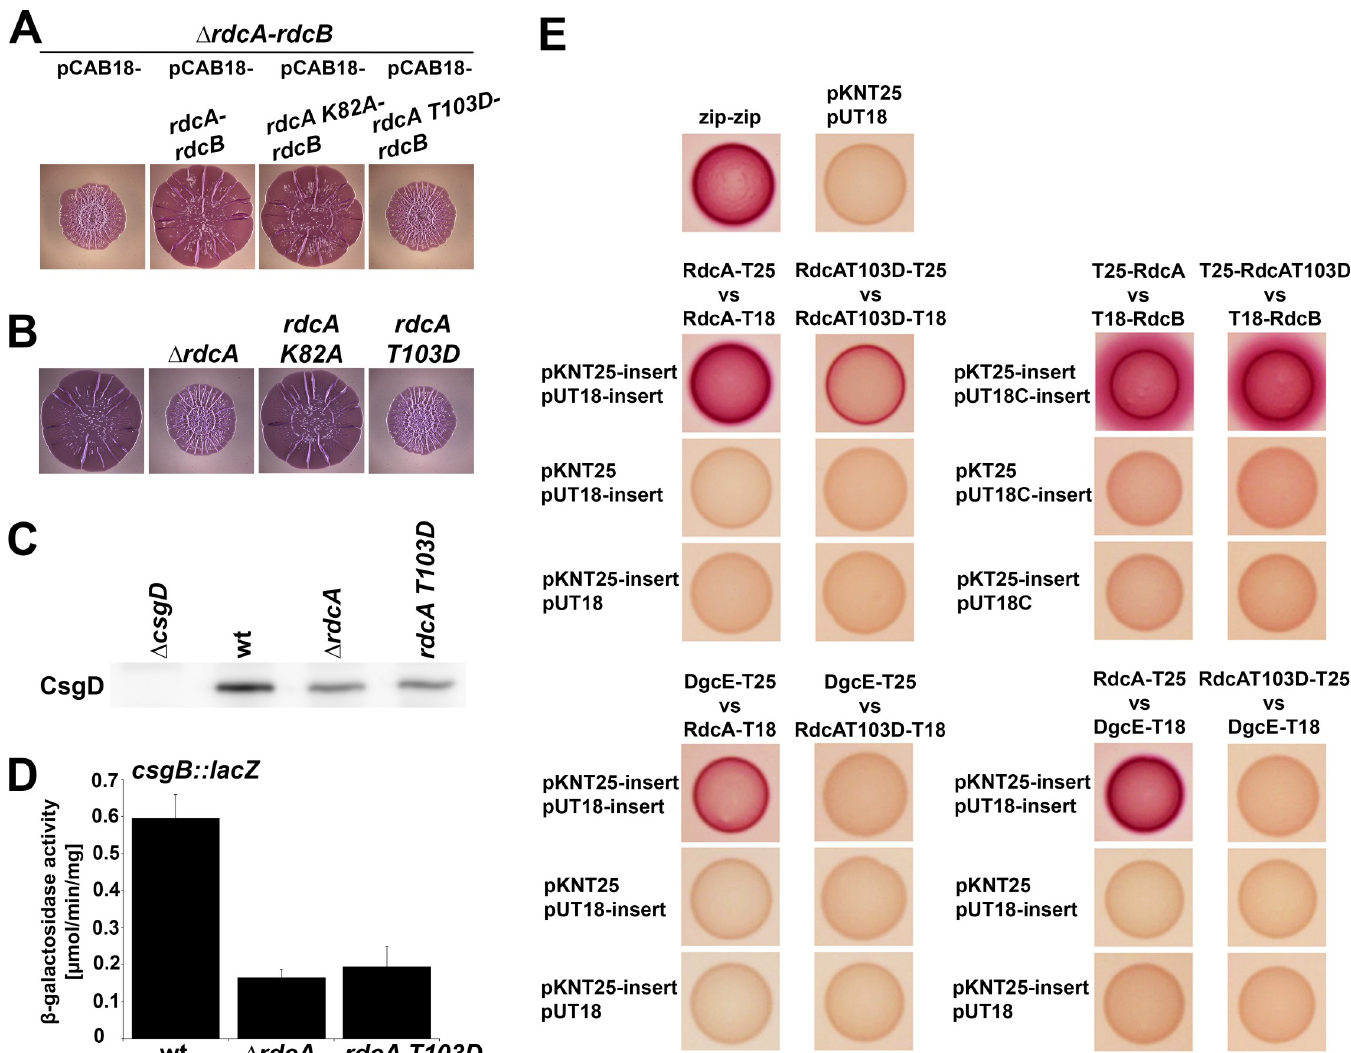
Fig 6. GTPase activity of RdcA is crucial for the activity of the RdcA-DgcE pathway. A: Macrocolony phenotypes of a Δ (rdcA-rdcB) derivative of strain AR3110 expressing the low copy number plasmid-encoded rdcA-rdcB operon containing either wildtype rdcA , rdcA K82A or rdcA T103D . Whereas the plasmid-encoded wildtype rdcA and rdcA K82A alleles show complementation, rdcA T103D is unable to complement. B: Macrocolony phenotypes of strain AR3110 carrying the indicated rdcA deletion and point mutations in the chromosome demonstrate that also under conditions of physiological expression, RdcA K82A can support matrix production, whereas RdcA T103D is unable to do so. C, D: The chromosomal rdcA T103D mutation, which eliminates the catalytic threonine required for GTPase activity of RdcA, phenocopies the complete rdcA knockout also with respect to the reduction in cellular CsgD levels as detected by immunoblot analysis ( C ) and curli expression as determined using the csgB :: lacZ reporter ( D ). E: Two-hybrid interaction assays revealing that the RdcA T103D variant shows reduced dimerization (middle panel, left side) and is unable to interact with DgcE (lower panels), while interaction with RdcB is not affected (middle panel, right side). Two-hybrid plasmid vectors used in each combination are listed at the side of each panel, with ’insert’ standing for the indicated proteins cloned into these vectors, vector names alone stand for the empty vectors in control combinations.